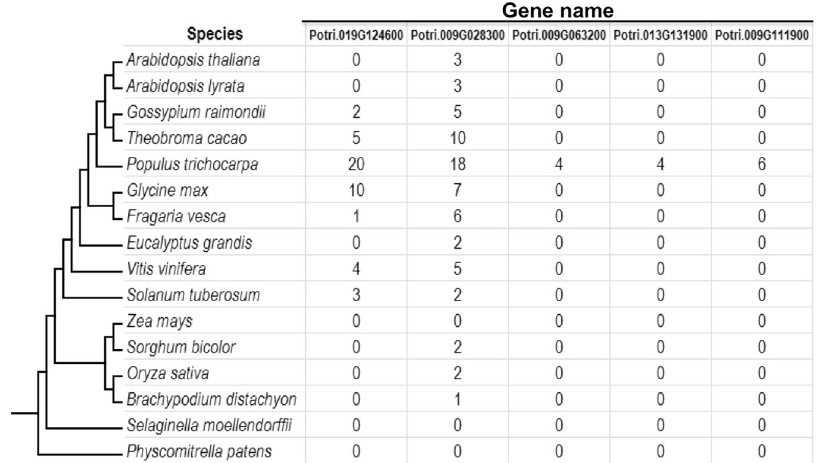
Figure 2. Lineage-specific expansion of small secreted proteins (SSPs) associated with Populus trichocarpa - Laccaria bicolor interaction. Due to space limitation, only five genes (Potri.019G124600, Potri.009G028300, Potri.009G063200, Potri.013G131900 and Potri.009G111900) showing lineage-specific expansion are shown in this figure. See Supplementary Tables S4 and S5 for details about the SSP genes showing lineage-specific expansion in Populus and closely related plant genera. The phylogenetic tree was adapted from http:// phytozome.jgi.doe.gov.